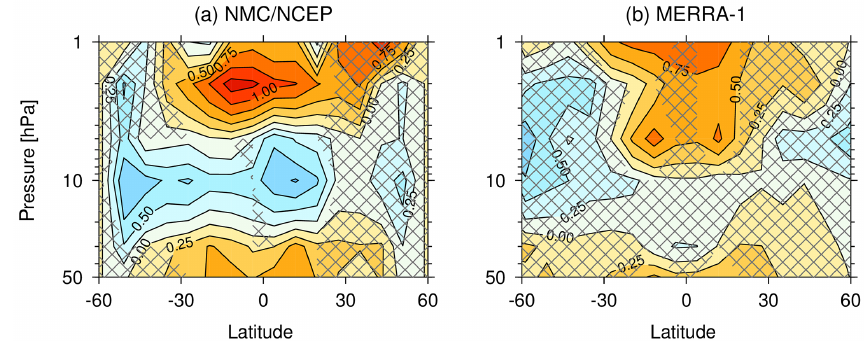
Figure 7. Eleven-year solar cycle signals in stratospheric temperature (K) from the (a) NMC/NCEP and (b) MERRA-1 datasets. Shading as in Fig. 4. The contour interval is 0.25K. These temperature fields are used in the post hoc conversion of SAGE II v6.2 number densities to mixing ratios (see Sect. 4.1.2 for